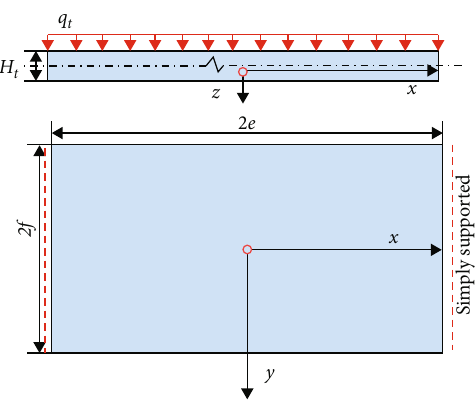
Figure 4: Mechanical model of suspended